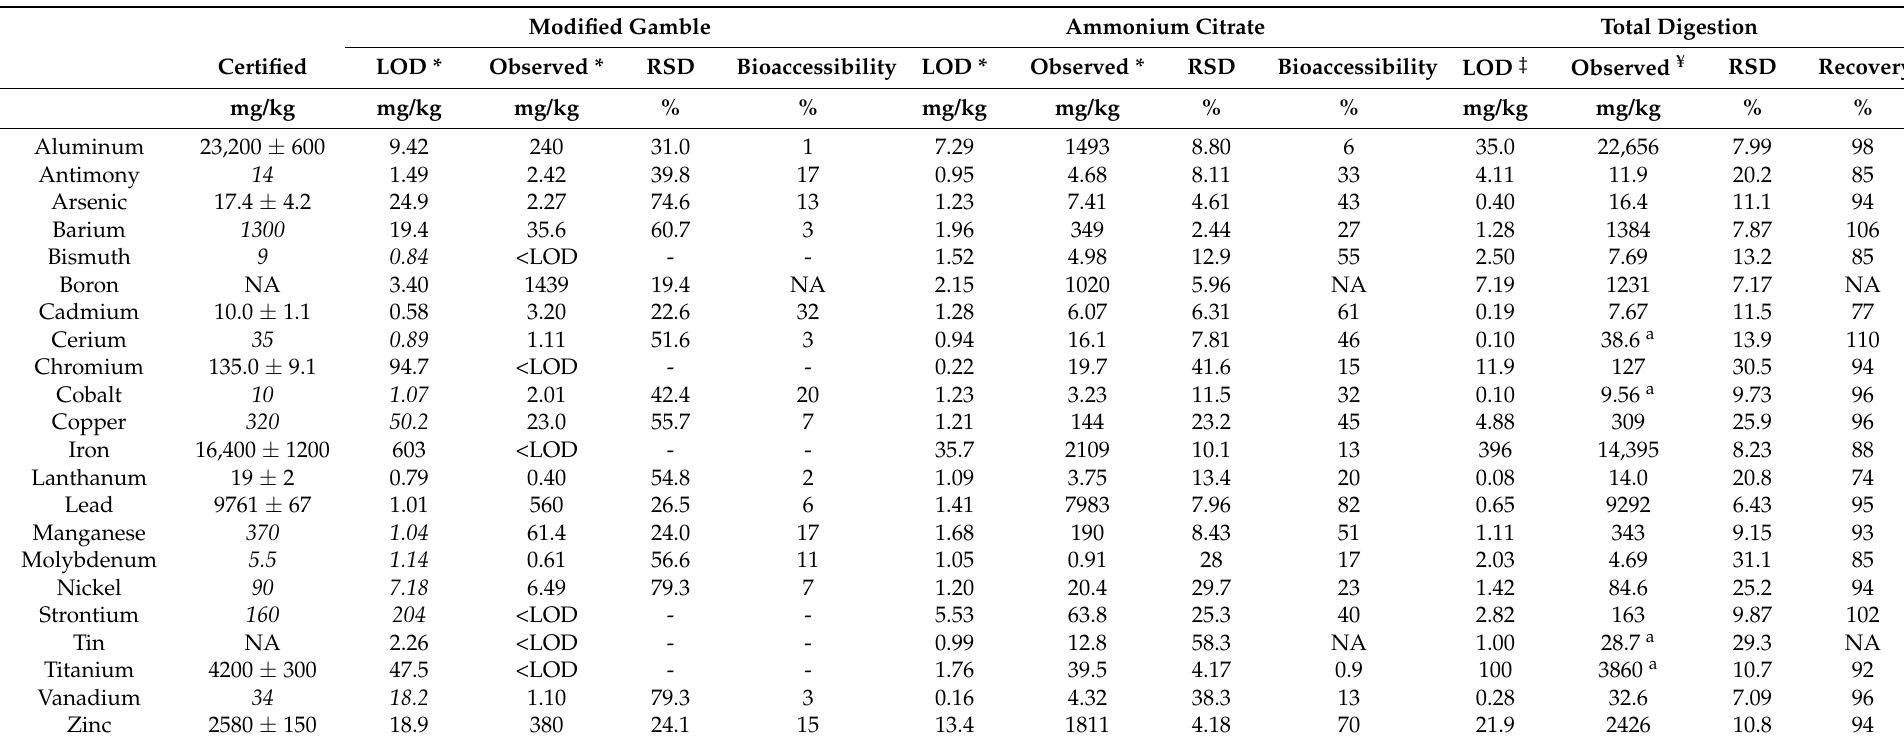
Table 2. Quality Assurance/Quality Control (QA/QC) for inductively coupled plasma (ICP) measurements of NIST 2584 following Gamble (* n = 6) and ammonium citrate (* n = 6) extractions and total digestion ( ¥ n = 11); limits of detection (LODs) were calculated based on 3 times the standard deviation of procedural blanks (* n = 6; ‡ n = 30); RSD = Relative Standard Deviation. (%RSD = Standard Deviation/mean expressed as